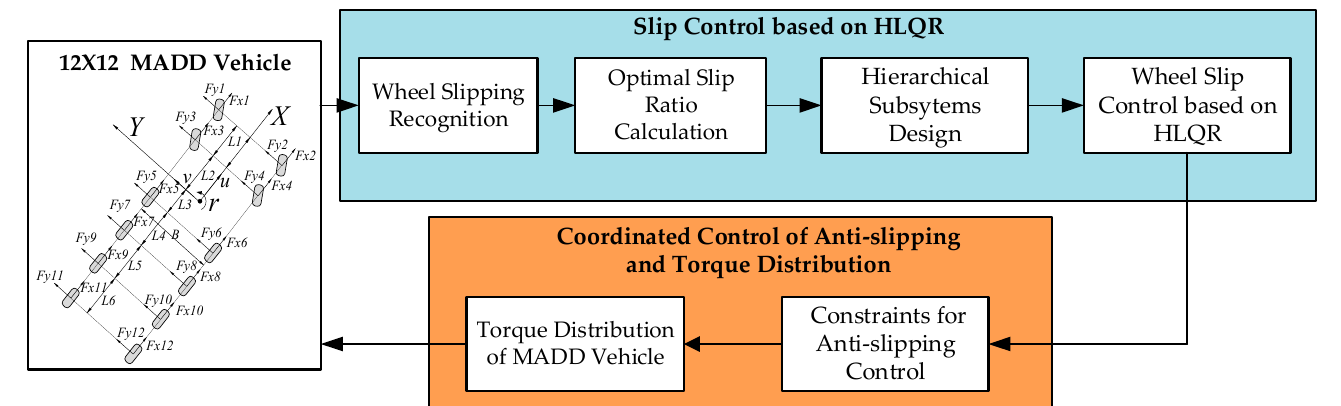
Figure 1. The coordinated slip control framework of the MADD vehicle.